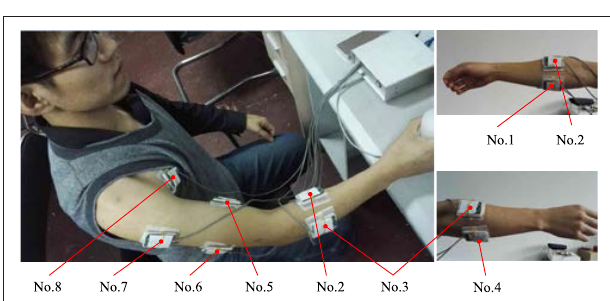
FIGURE 10 | The distribution of the EMG sensors.